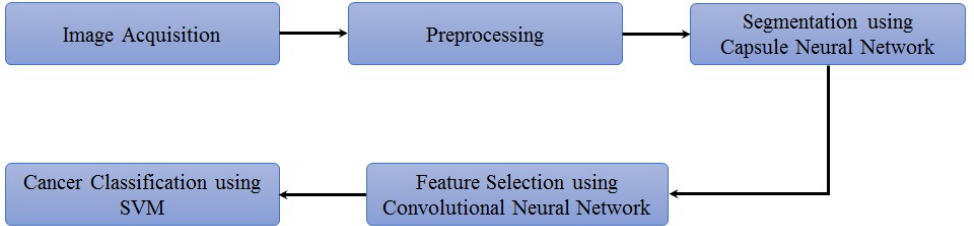
Figure 2. Flow of the proposed